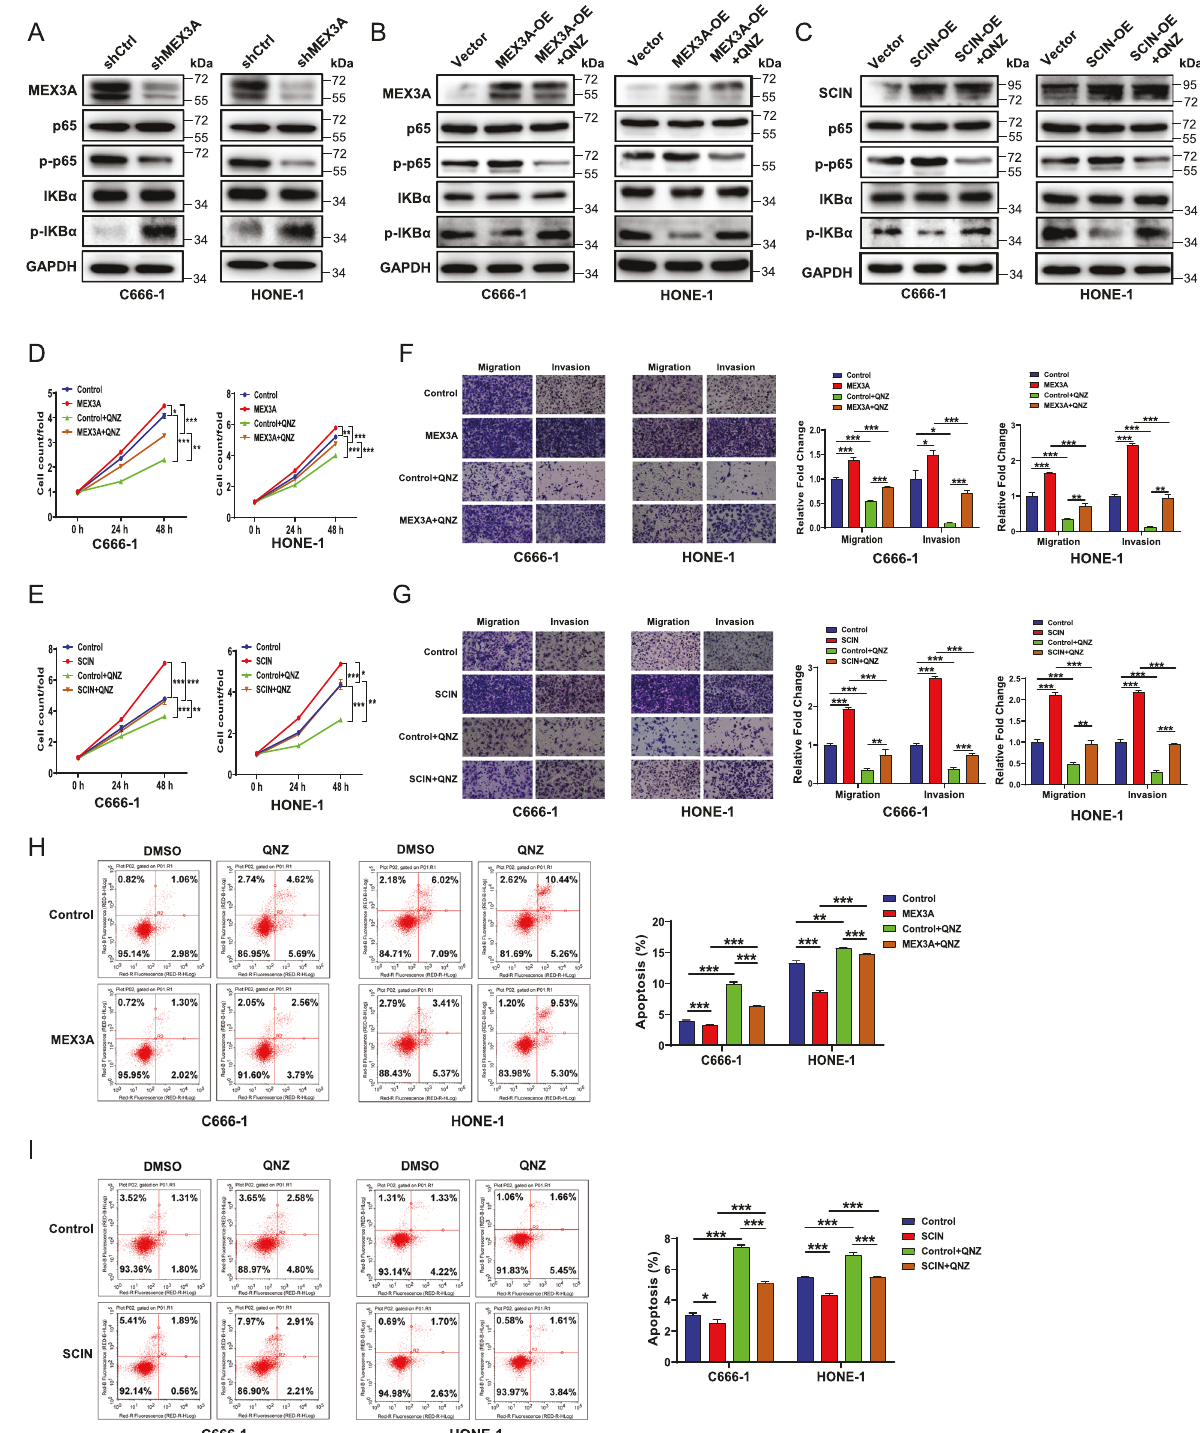
Fig. 7 MEX3A and SCIN regulate NPC likely via the NF- κ B signaling pathway. A The major components of the NF- κ B pathway in shCtrl and shMEX3A stable C666-1 and HONE-1 cell lines were detected by western blotting. B , C The effects of treatment with NF- κ B inhibitor QNZ (EVP4593) on MEX3A ( B ) or SCIN ( C ) overexpression in human C666-1 and HONE-1 NPC cells were determined by western blotting. D , E The effects of QNZ compared with those of negative control (DMSO) on the proliferation of C666-1 and HONE-1 cells with or without MEX3A ( D ) or SCIN ( E ) overexpression were detected by CCK-8 assay. F , G The impact of QNZ on the migration and invasion abilities of indicated cells with or without MEX3A ( F ) or SCIN ( G ) overexpression was measured by Transwell assay. H , I The impact of QNZ on the apoptosis rates of indicated cells with or without MEX3A ( F ) or SCIN ( G ) overexpression was measured by fl ow cytometry. The results are presented as mean ± SD. * P < 0.05, ** P < 0.01, *** P < 0.001.